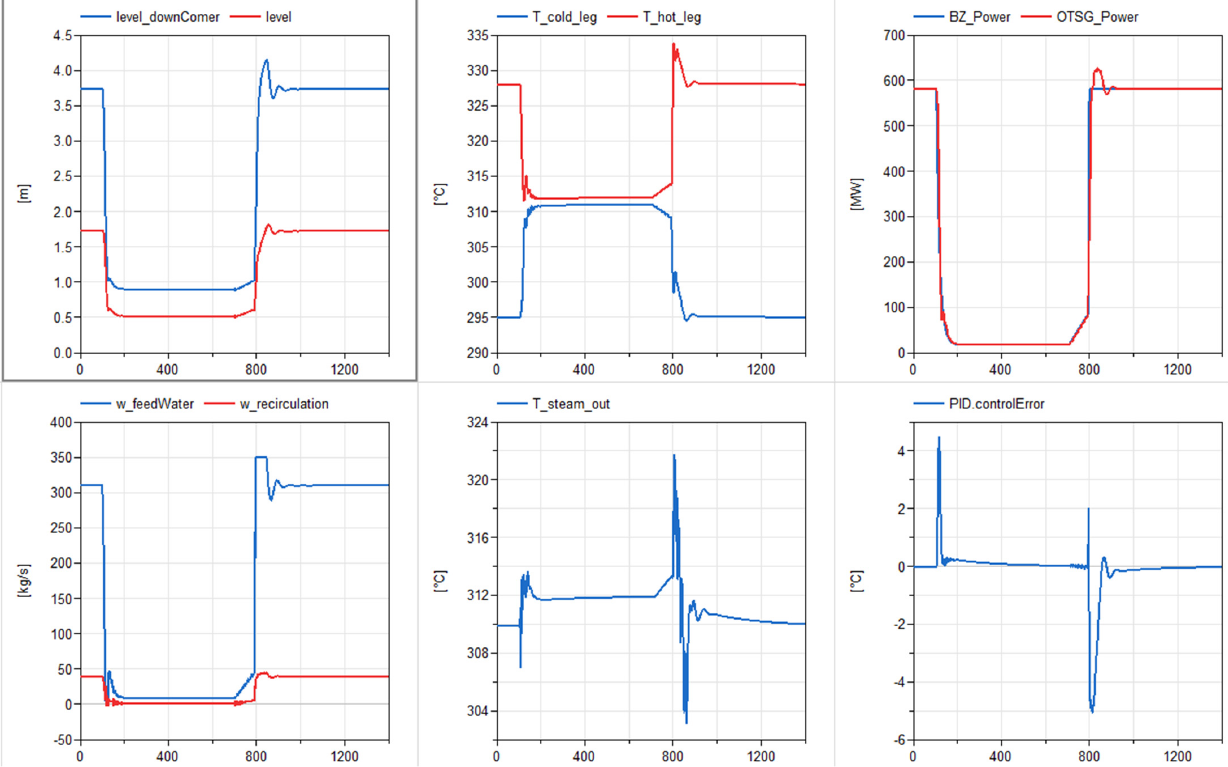
Figure 3. Simulation results for control logics 1 during pulse–dwell–pulse transitions. Pulse ‐ >dwell starts at 100 s, dwell ‐ >pulse starts at 700 s.